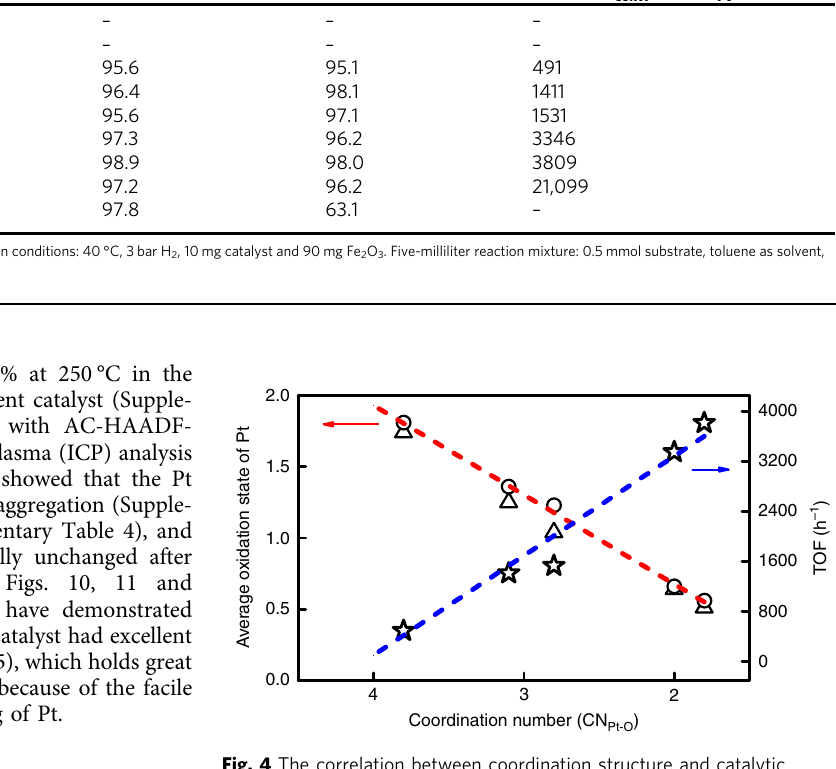
Table 2 Chemoselective hydrogenation of 3-nitrostyrene over Pt 1 /Fe 2 O 3 -T catalysts Catalyst